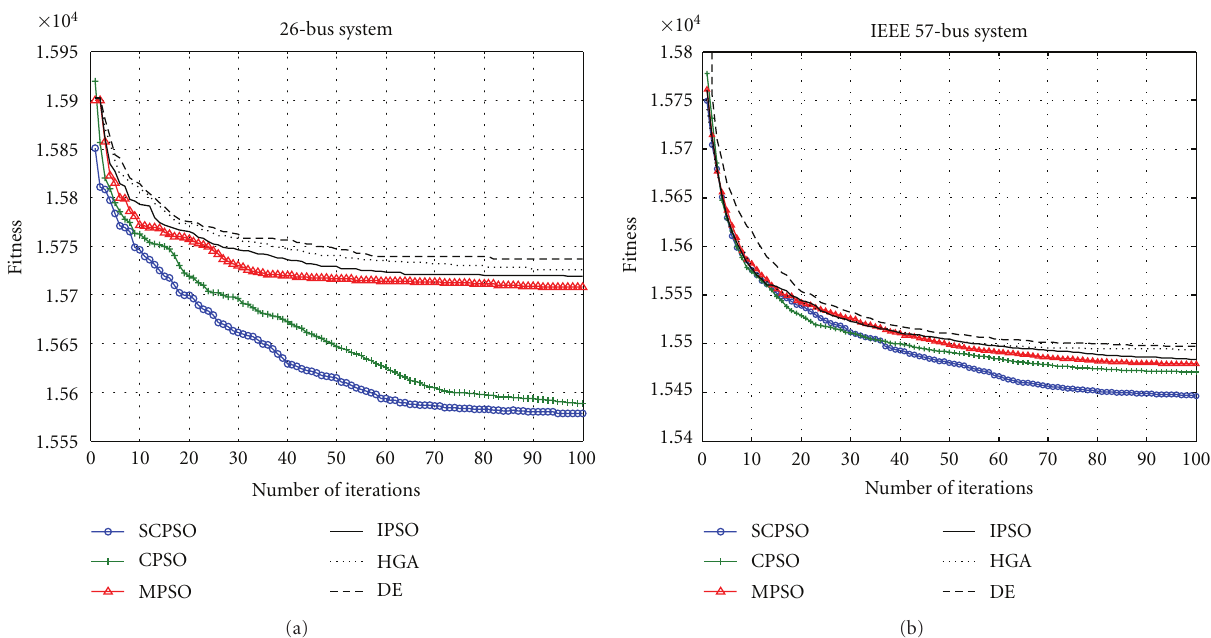
Figure 6: Convergence tendency. (a) Convergence tendencies of average fitness over 30 trials in 26-bus system. (b) Convergence tendencies of average fitness over 30 trials in IEEE 57-bus